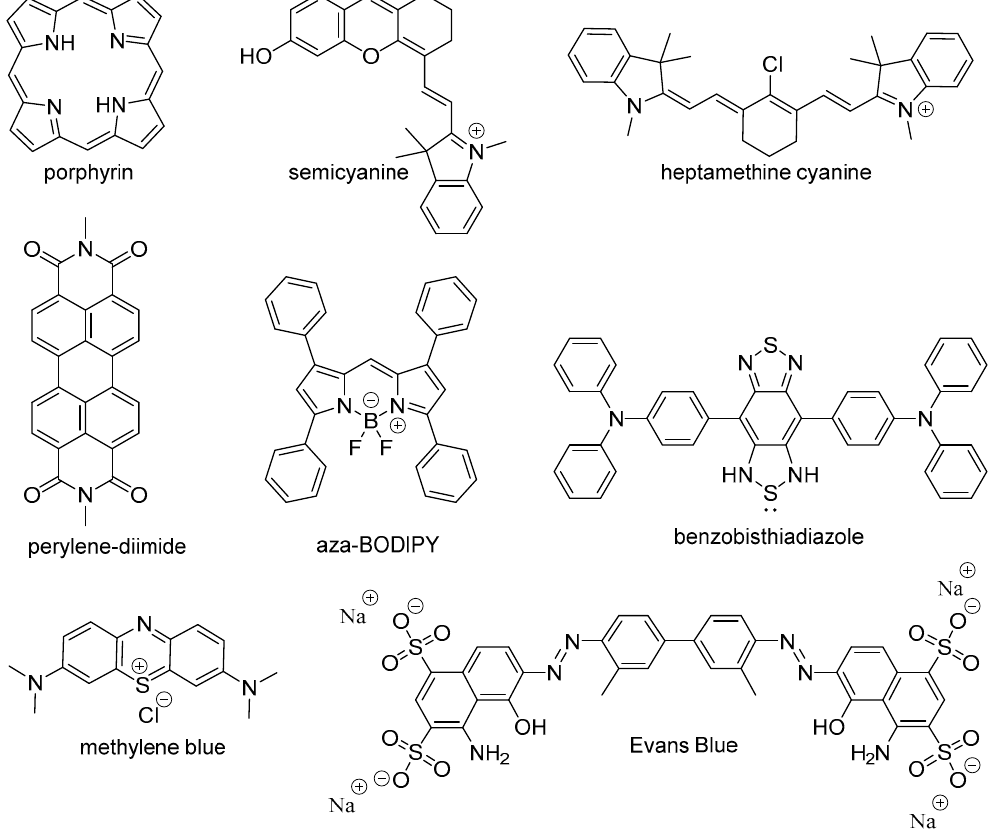
Figure 3. Basic chemical structures of organic ‐ dye ‐ based PA probes.